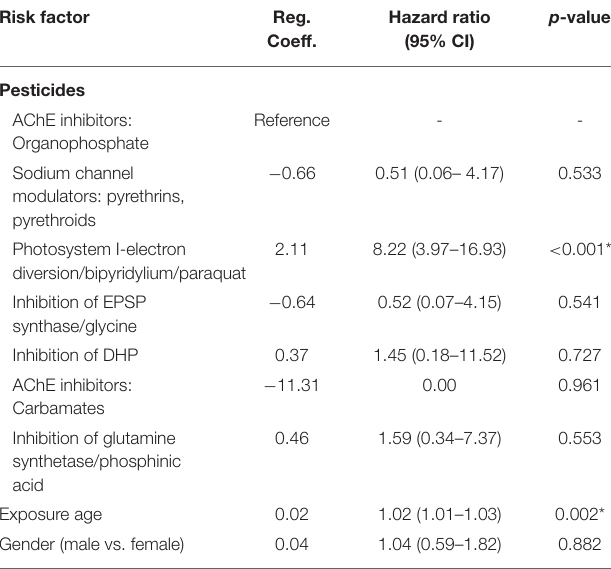
TABLE 3 | Cox proportional-hazard analysis of